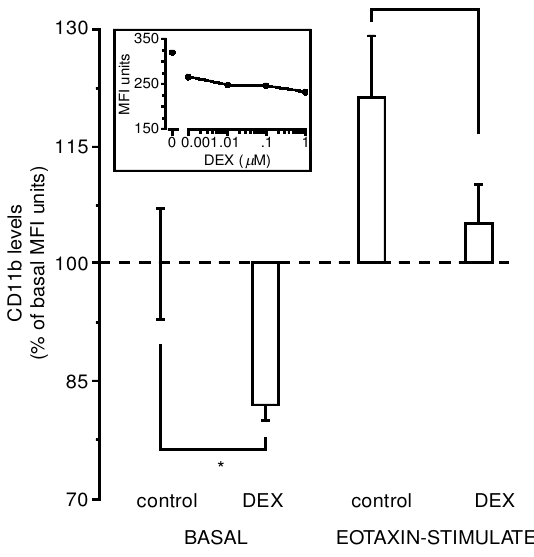
FIG. 2. The effect of DEX on basal or eotaxin-stimulated CD11b levels on Eù s. Eù s were incubated for 18 h with either buffer (control) or 0.1 m M DEX. Cell surface CD11b levels were measured either immediately (basal) or after the cells were incubated with either buffer or 100 ng / ml hr eotaxin for a further 30 min at 37 8 C. Basal value (100%) was 347 MFI units. Data are mean SEM from three to four experiments performed in duplicate. The insert shows a typical dose response to DEX on basal CD11b levels. P , 0.05 when compared with control (calculated on original values).